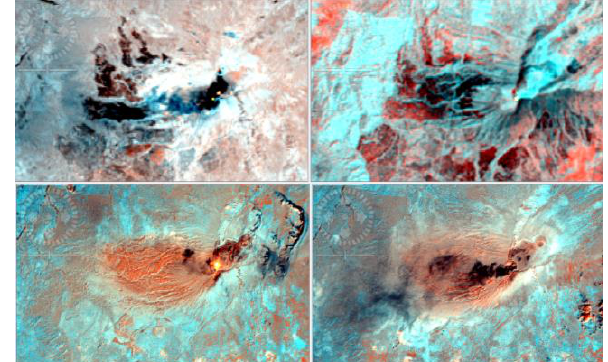
Figure 2. Crosta’s technique RGB combination Ar,Ar+Fe,Fe for Turrialba volcano area in 07/04/2013 (left up ALI), 05/09/2013 (right up Hyperion), 26/01/2017 (left down Sentinel 2) and 12/12/2018 (right down Sentinel